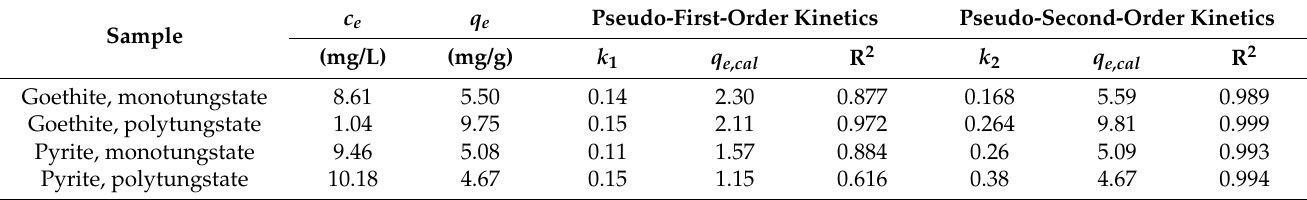
Figure 4. Pseudo-first-order ( a ) and pseudo-second-order ( b ) models for monotungstate and polytungstate adsorption on goethite. Pseudo-first-order ( c ) and pseudo-second-order ( d ) models for monotungstate and polytungstate adsorption on pyrite. Table 3. Kinetics constants for tungsten sorption onto goethite and pyrite.